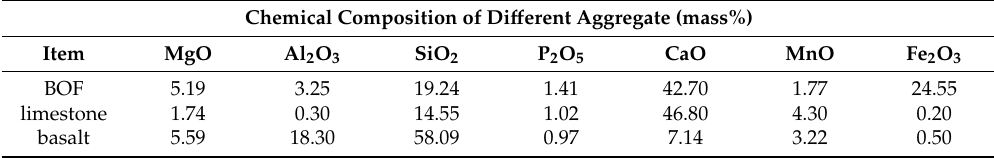
Table 2. X-ray fluorescence (XRF) test results of di ff erent aggregates